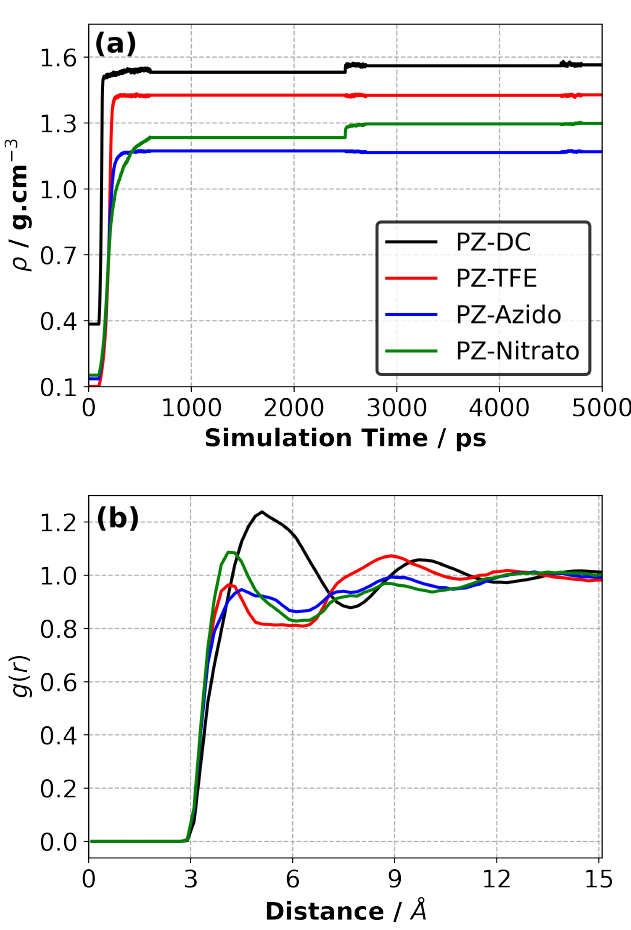
Figure 2. ( a ) Density evolution of liquid samples at 50 ◦ C and 1 atm. ( b ) Radial distribution function between head (P) and tail (N) of PZ